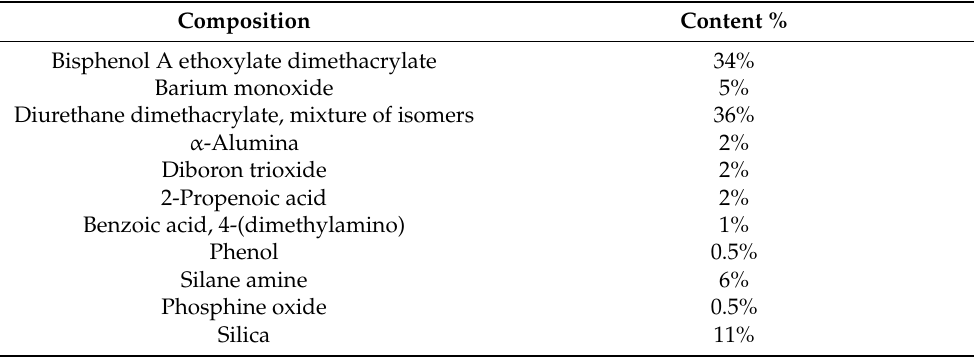
Table 1. Composition of ortho connect flow.